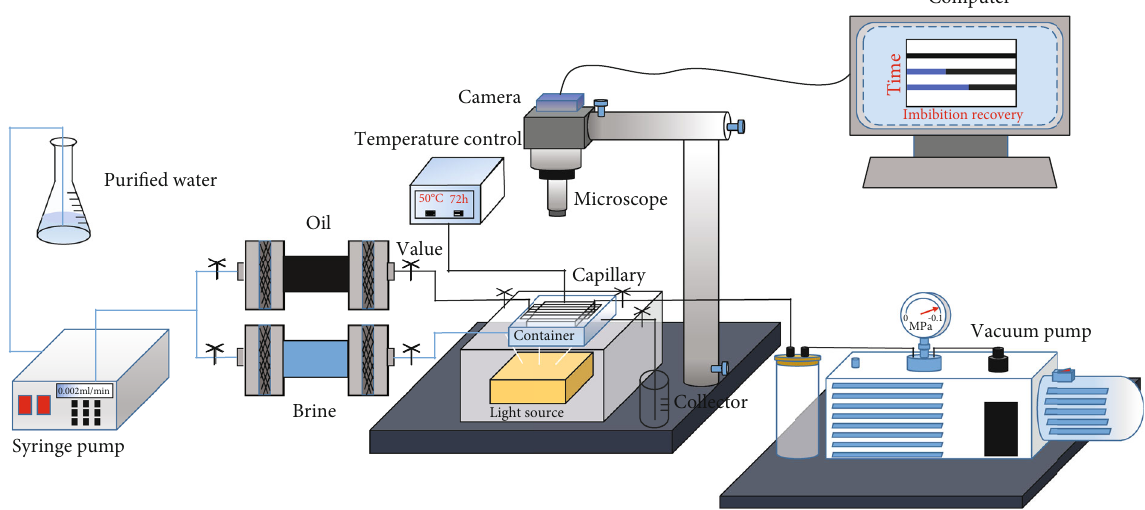
Figure 2: Schematic diagram of visualized spontaneous imbibition